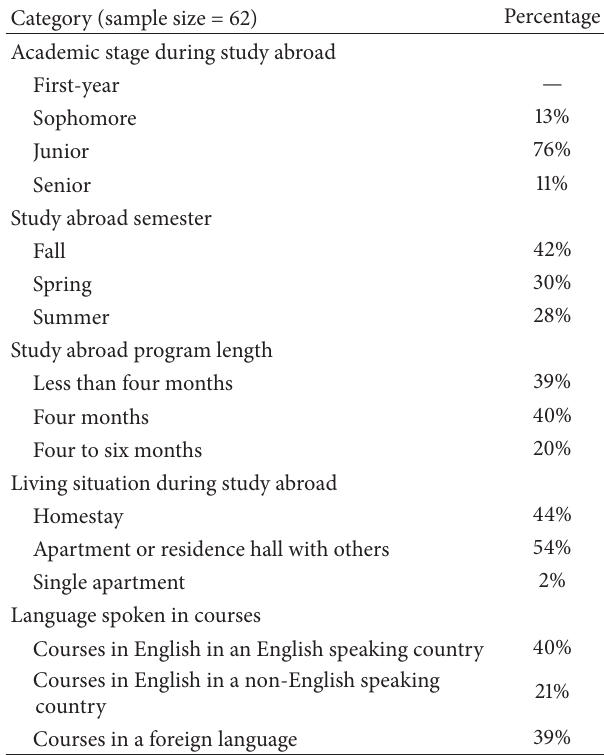
Table 2: Additional demographic